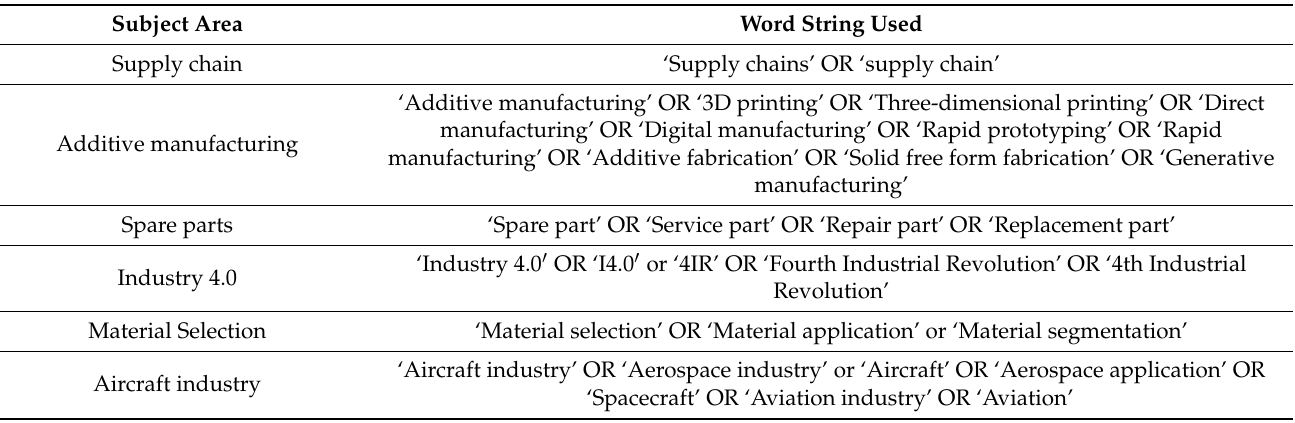
Table 3. Word Strings for publication